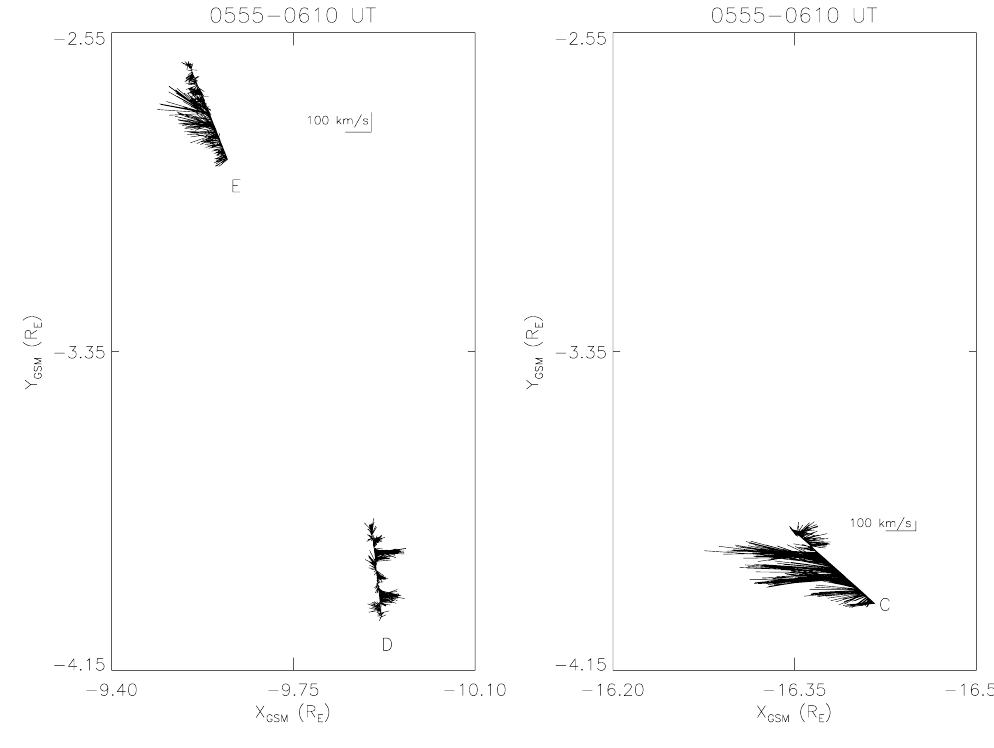
Fig. 1. The positions of Themis C (right), D and E (left) for the period 05:55–06:10UT in the XY GSM -plane, with Earth to the left. Overlaid are the observed velocity vectors. The event is in the center of this interval and all three satellites move towards more negative Y GSM